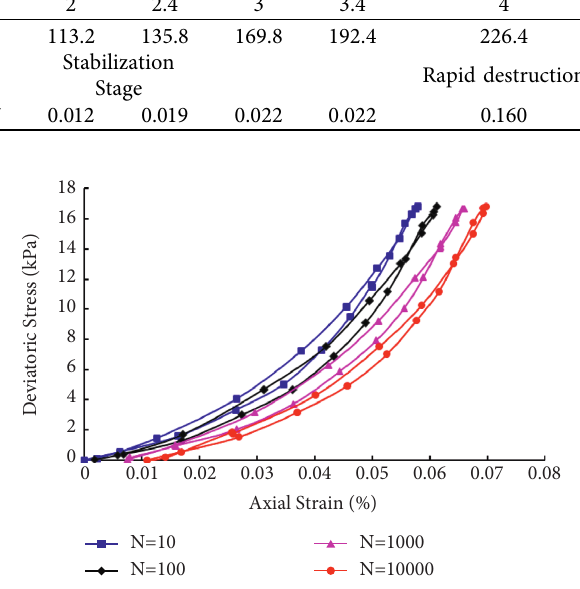
Figure 8: Hysteretic curve of different cycle times (dynamic stress 2 σ d � 16 . 9 kPa).